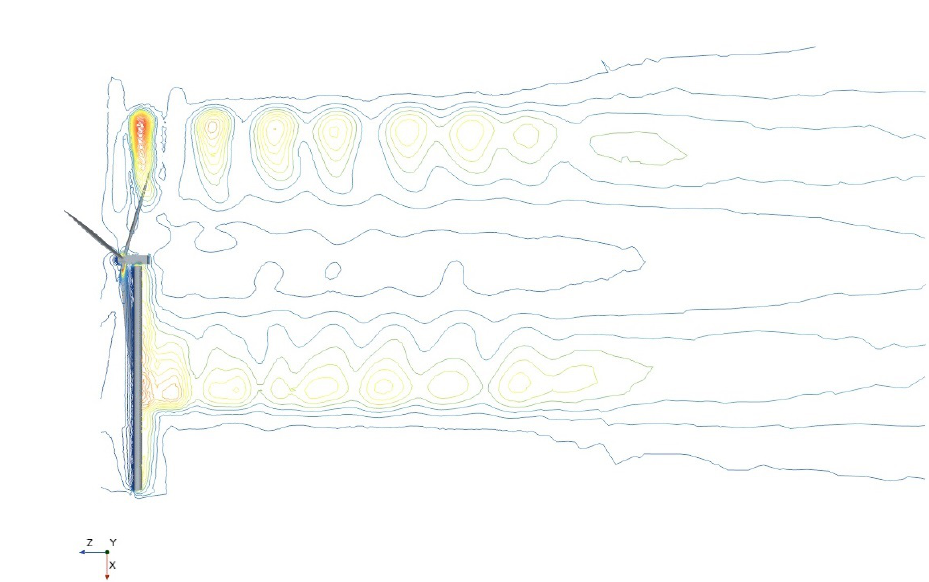
Figure 15. Scalar scene total energy in the near